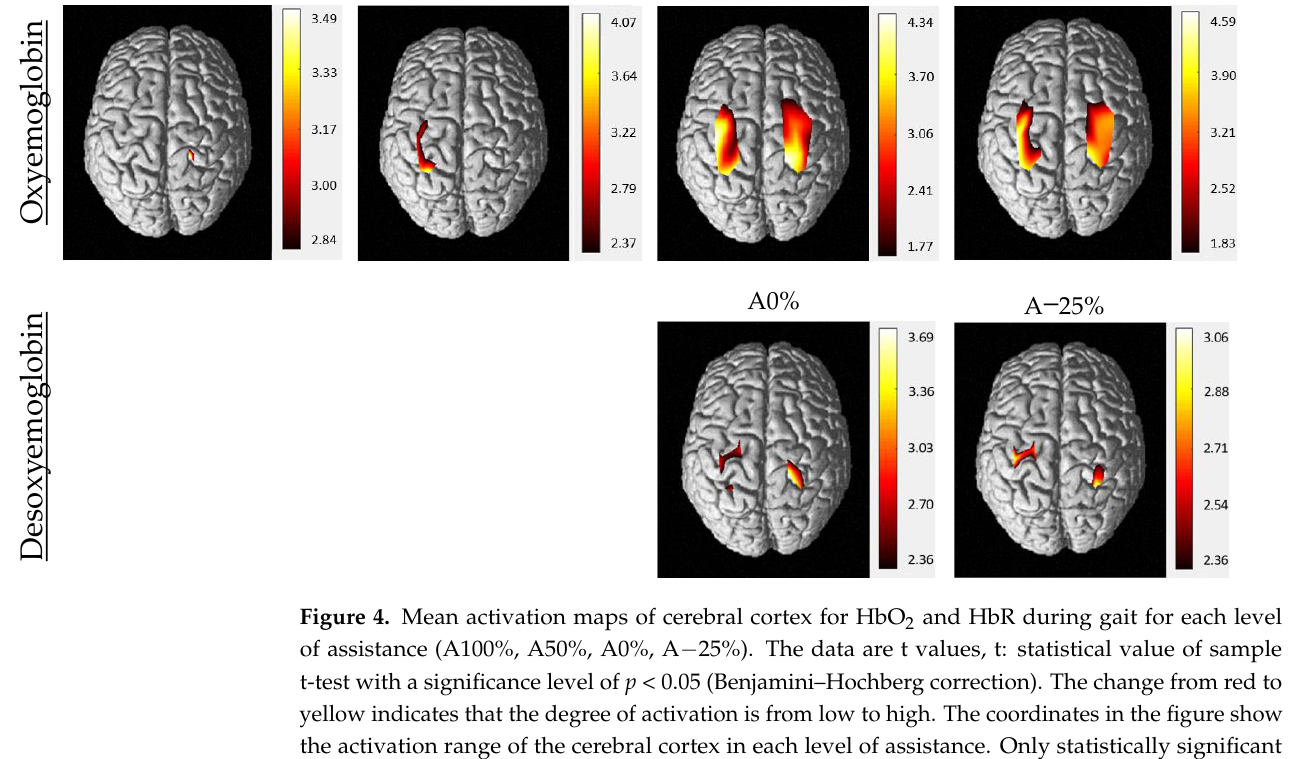
7 of 16 Figure 3. Results of the hemodynamic response by level of assistance (A100%, A50%, A0%, A−25% ) for each channel. The results are expressed by mean (average of the participants). Graph locations